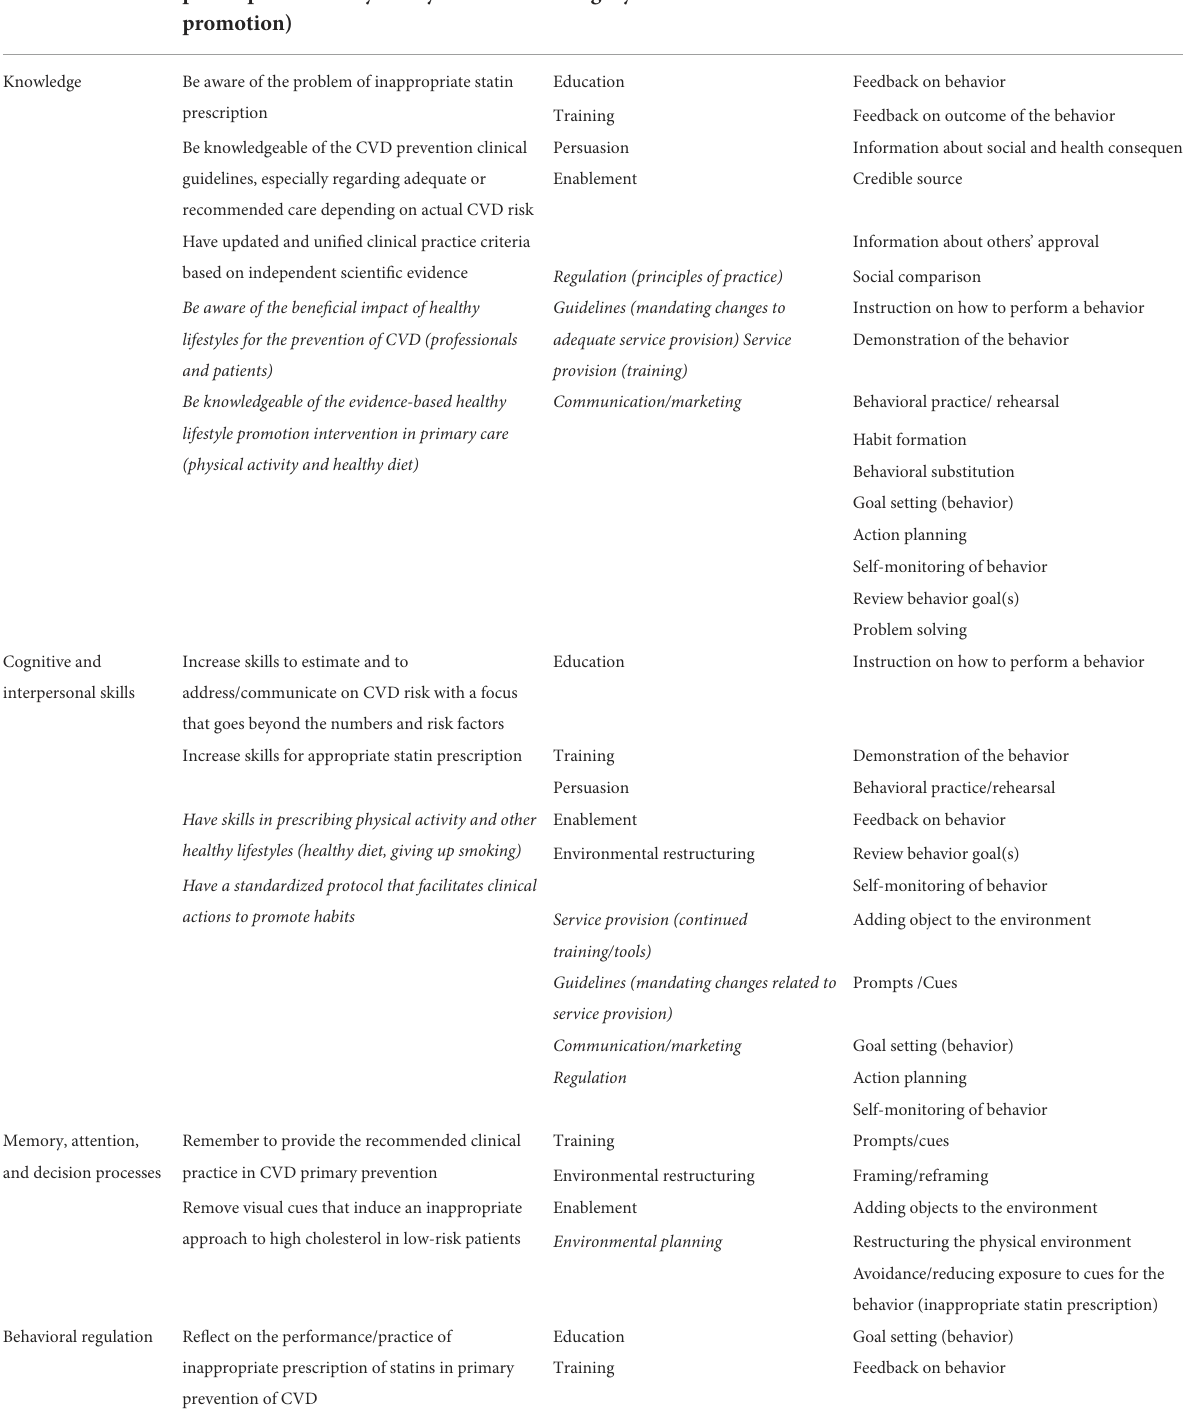
TABLE 2 Mapping matrix of potential intervention functions, policy categories and Behavior Change Techniques (BCI) to previously identified determinants of inappropriate statin prescription and healthy lifestyle promotion categorized by Theoretical Domains Framework (TDF) dimensions identified from the qualitative